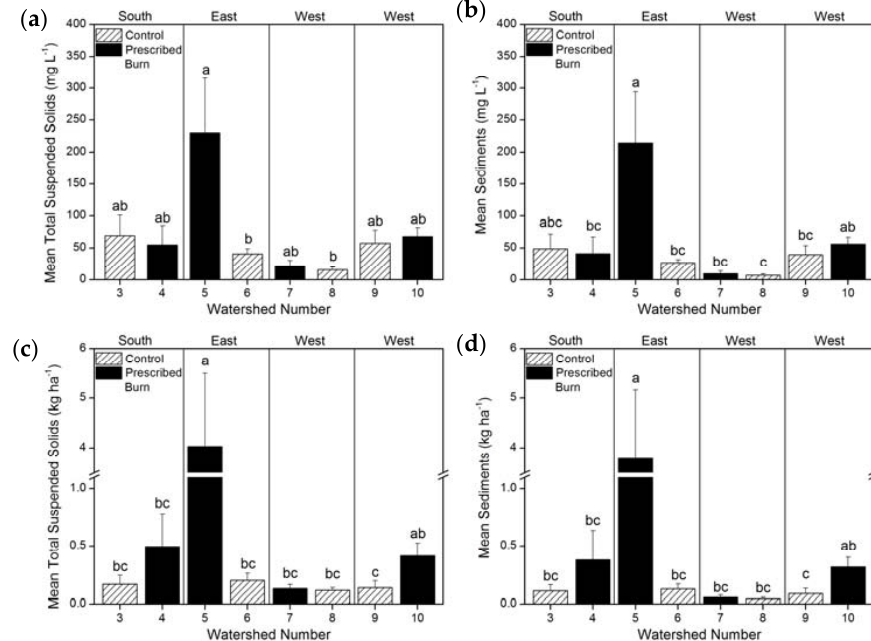
Figure 7. Comparisons of mean ±95% confidence interval (CI) for post ‐ burn ( a ) total suspended solids concentration, ( b ) sediments concentration, ( c ) total suspended solids loads, and ( d ) sediment loads by treatments in paired ‐ watersheds. Significant differences ( p values < 0.05) are noted by different letters at the top of each bar.